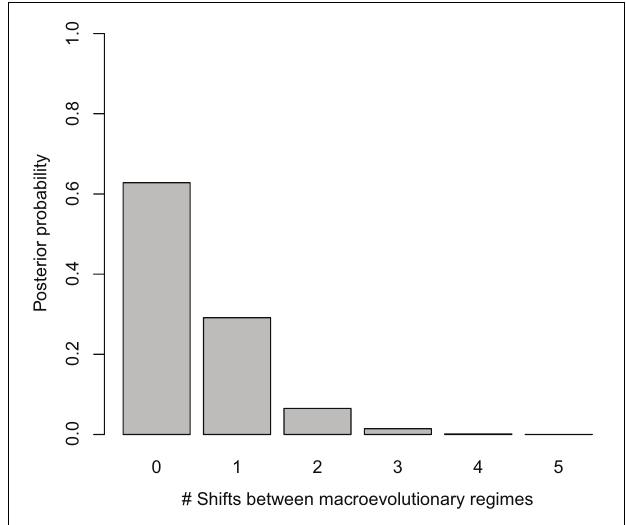
FIGURE 2 | Posterior probability of models with different number of shifts between macroevolutionary regimes considered in BAMM. The best models for Manilkara s.s. indicate no significant shifts in